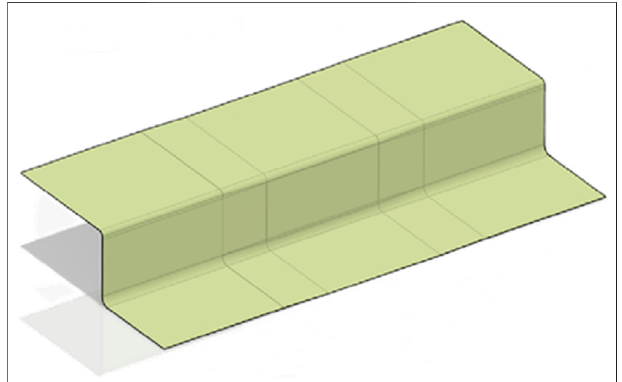
FIGURE 5 | Representative geometry used for forming